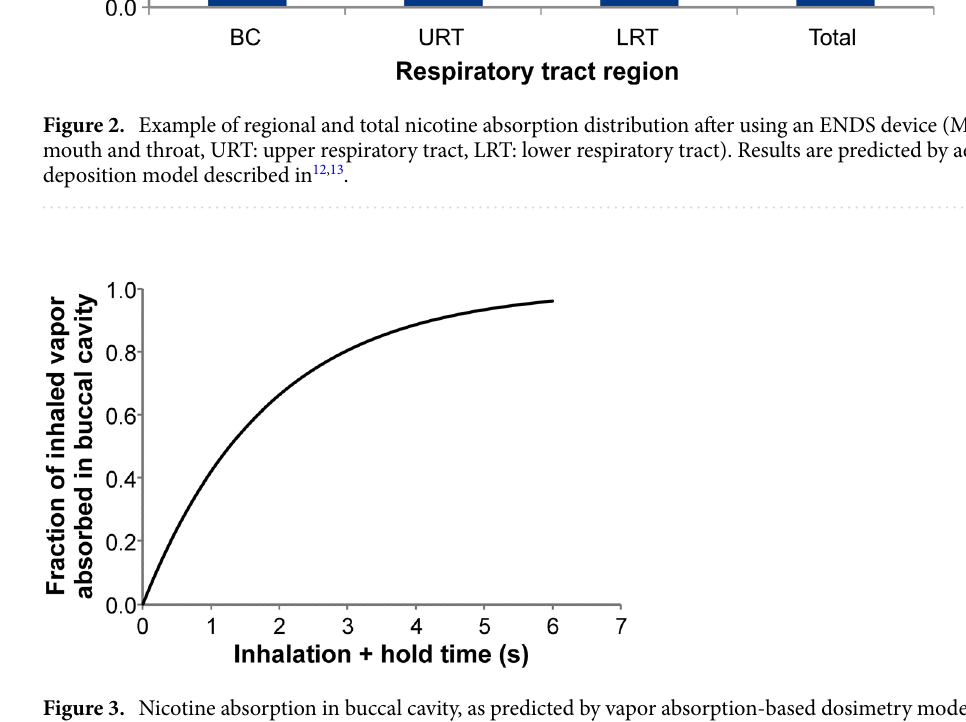
Figure 3. Nicotine absorption in buccal cavity, as predicted by vapor absorption-based dosimetry model (Eq. 1) as a function of total inhalation and mouth hold